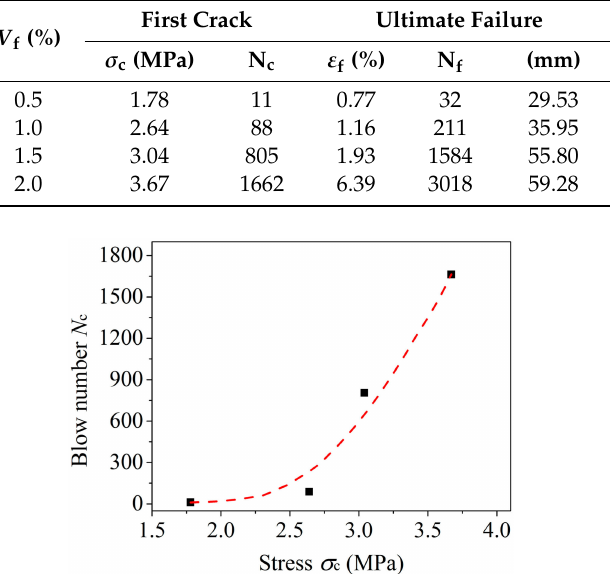
Figure 13. Relation between N c and σ c